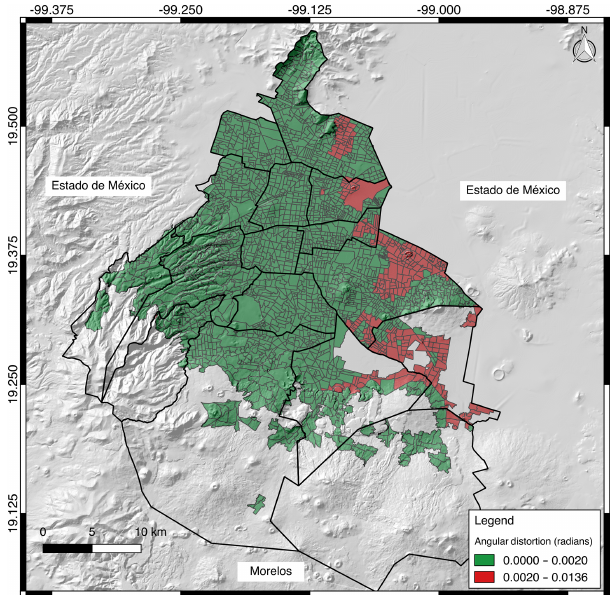
Figure 4. Angular distortion map of Mexico City. The shaded to- pographic base layer is taken from Continuo de Elevaciones Mex- icano 3.0. © Instituto Nacional de Estadística Geografía e Infor- mática (INEGI).